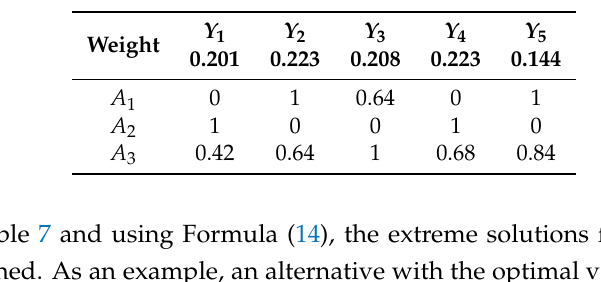
Table 7. Normalized defuzzified decision matrix by the trade-off ranking.